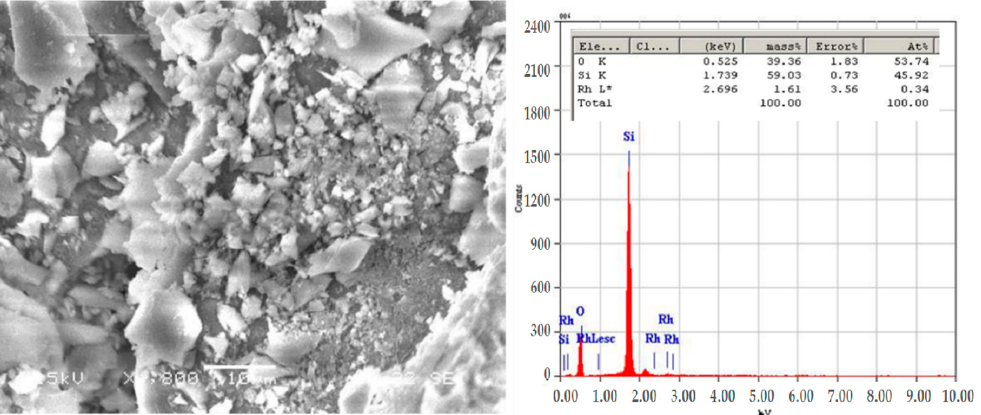
Figure 3. Left panel : The SEM micrograph of the Rh-1 sample. Right panel : the corresponding EDX analysis, inset: the elemental analysis as obtained from EDX